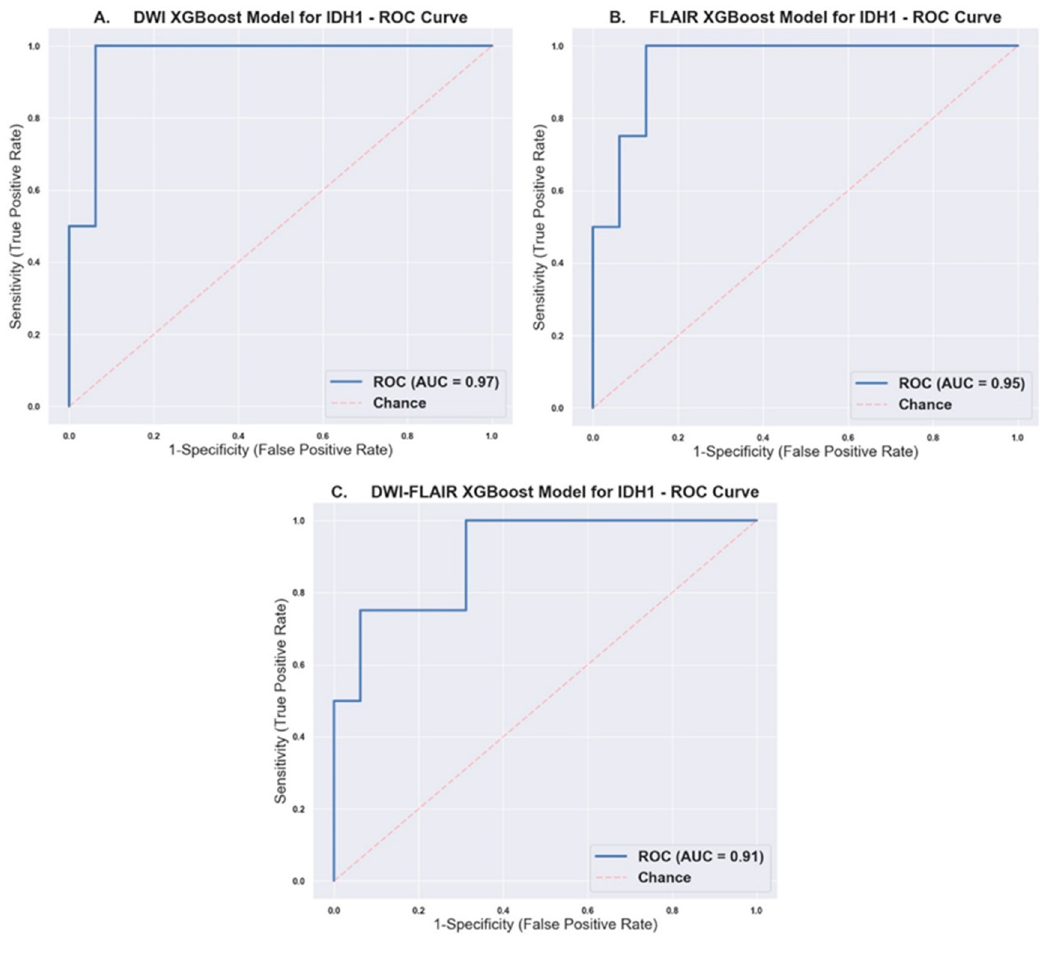
Figure 1. Receiver Operating Characteristic Curves with calculated AUC for ( A ) Diffused Weighted Imaging (DWI), ( B ) Fluid-Attenuated Inversion Recovery (FLAIR), and ( C ) DWI-FLAIR XGBoost models. Table 4. Top 10 Most Important Radiomic Features Ranked By Gain for Each Model.